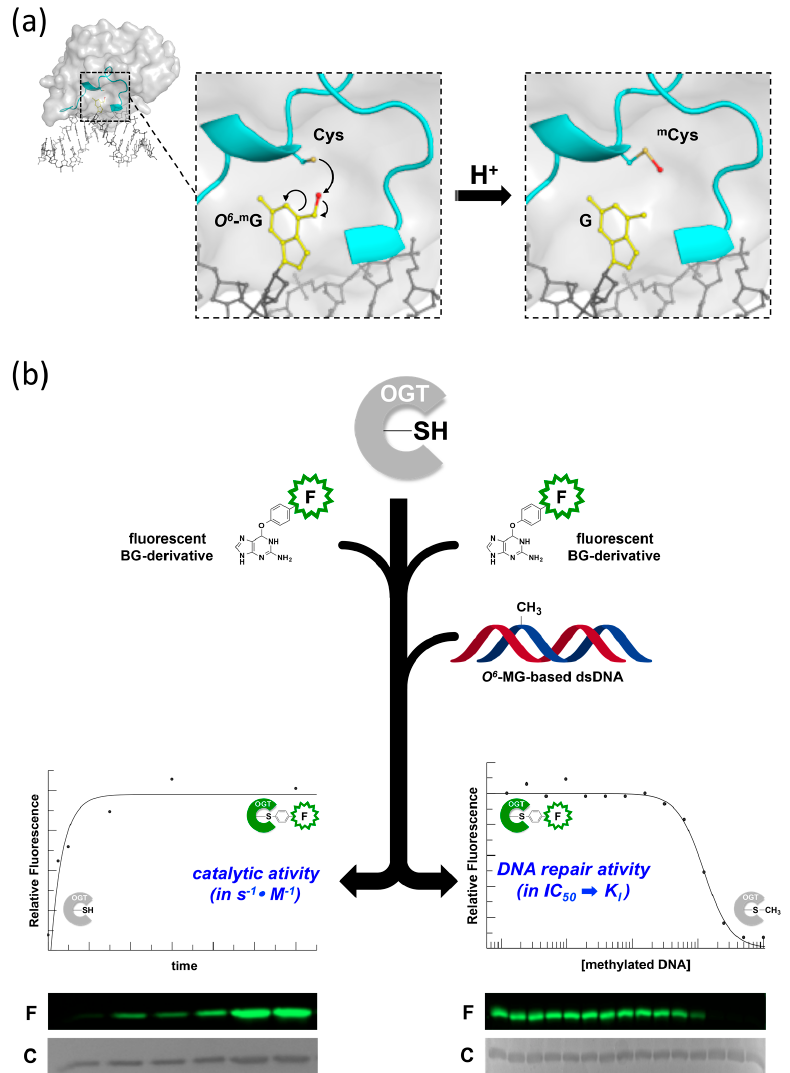
Figure 1. The DNA repair reaction by O 6 -DNA-alkyl-guanine-DNA-alkyl-transferases (OGTs). ( a ) Upon DNA binding, OGT flips-out the damaged guanine from the DNA backbone and irreversibly transfers the alkyl group to its own catalytic cysteine. ( b ) The covalent bond between the alkyl group and the cysteine allowed developing a new assay, by using O 6 -BG fluorescent derivatives alone ( left panel ), or in combination with natural non-fluorescent alkylated-DNA substrates ( right panel ).